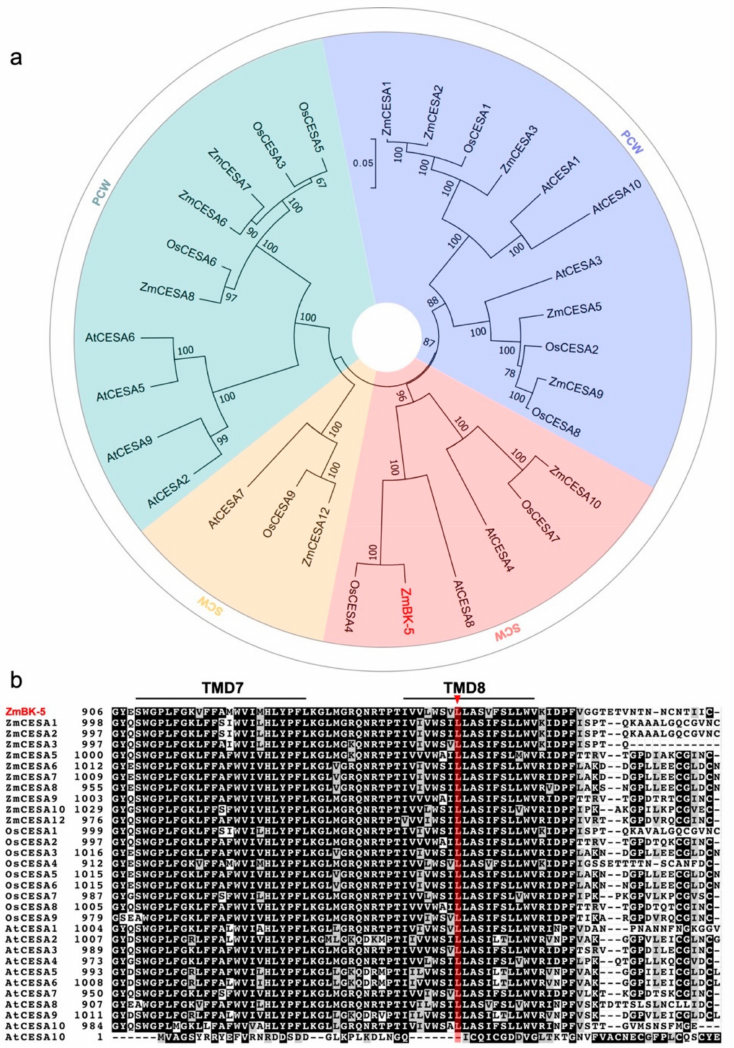
Figure 5. Evolutionary relationships and sequence analysis of BK-5. ( a ) Evolutionary relationships of CESA family. The evolutionary history was inferred using the Neighbor-Joining method. The optimal tree with the sum of branch length = 1.88966750 is shown. The tree is drawn to scale, with branch lengths in the same units as those of the evolutionary distances used to infer the phylogenetic tree. The evolutionary distances, in the units of the number of amino acid substitutions per site, were computed using the JTT matrix-based method. All positions containing gaps and missing data were eliminated. The red diamond represents the branch where ZmBK-5 was located. Four different colored backgrounds represent different primary branches, green and blue backgrounds proteins belong to primary cell wall (PCW), and yellow and pink background proteins belong to secondary cell wall (SCW). The analysis involved 30 amino acid sequences. Evolutionary analy- ses were conducted in MEGA7. ( b ) Sequence alignment analysis of ZmBK-5 and its homologues. The sequence alignment was completed by ClusterW module of MEGA7, and the similarity value was obtained by ClusterW online (https://www.genome.jp/toolsbin/clustalw, 29 October 2021). The sequence was visualized by boxshade (https://embnet.vi-talit.ch/software/BOX_form.html, 29 October 2021). The red bottom line stands for Cation_ efflux domain, forecast through Pfam (http://pfam.xfam.org/search/sequence, 29 October 2021). The red triangle represented all allelic mutation